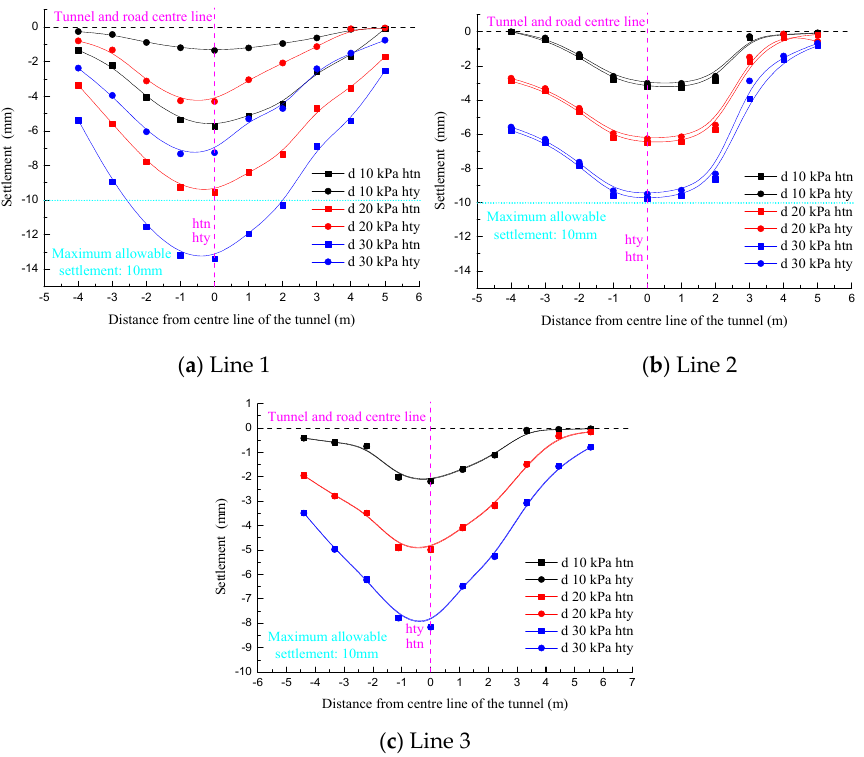
Figure 14. Longitudinal surface settlement of model D-D with D/W = 0.378.